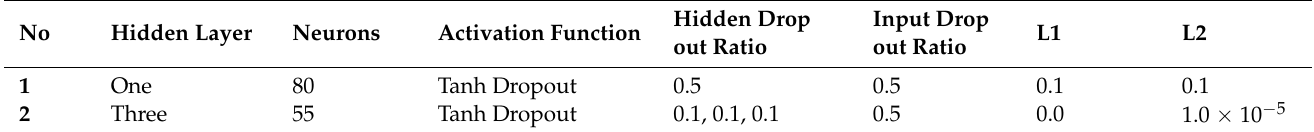
Table 6. Optimal hyperparameters selected based on performance on training, CV, and test datasets.